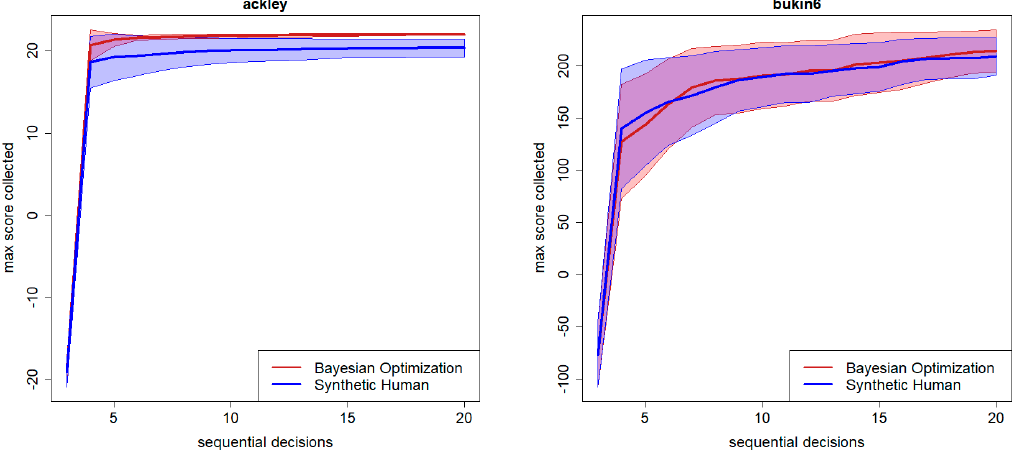
Figure 5. Max score observed over sequential decisions: cases with BO and SH offering similar per- formances.